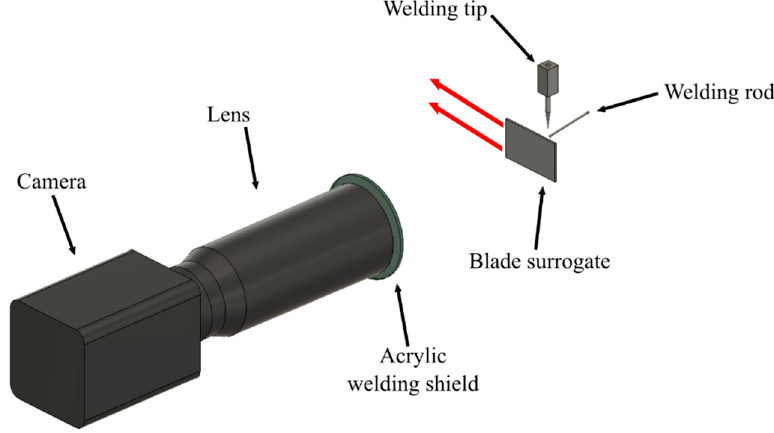
Figure 1. Representation of the experimental setup. The red arrows represent the direction of motion of the blade surrogate.